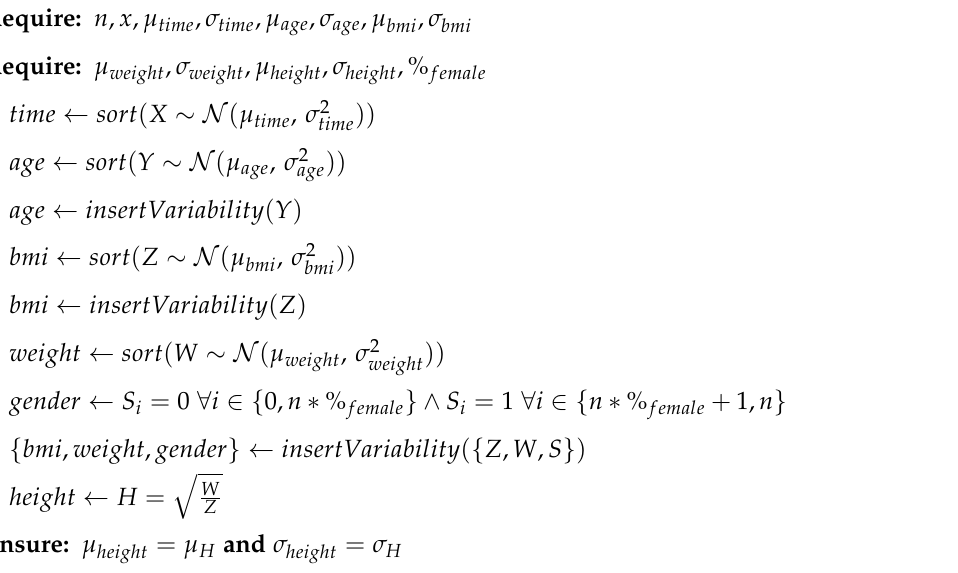
Algorithm 1 Generate features for n datapoints of Class x